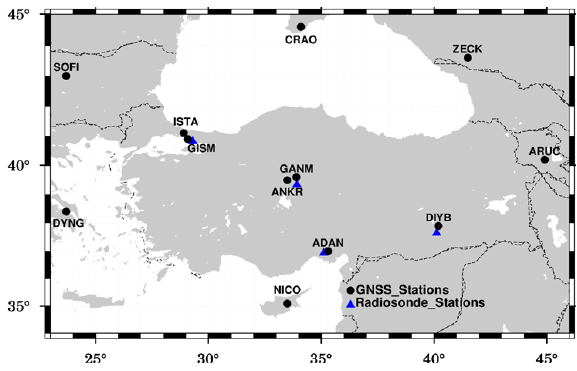
Figure 1. Co-located radiosonde and GNSS stations Wyoming Department of Atmospheric Science's web site.